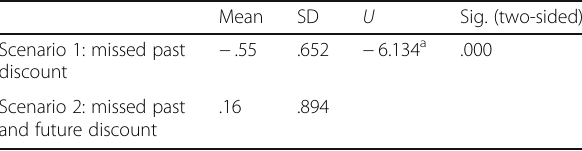
Table 3 Mean regret scores by order of missed opportunity